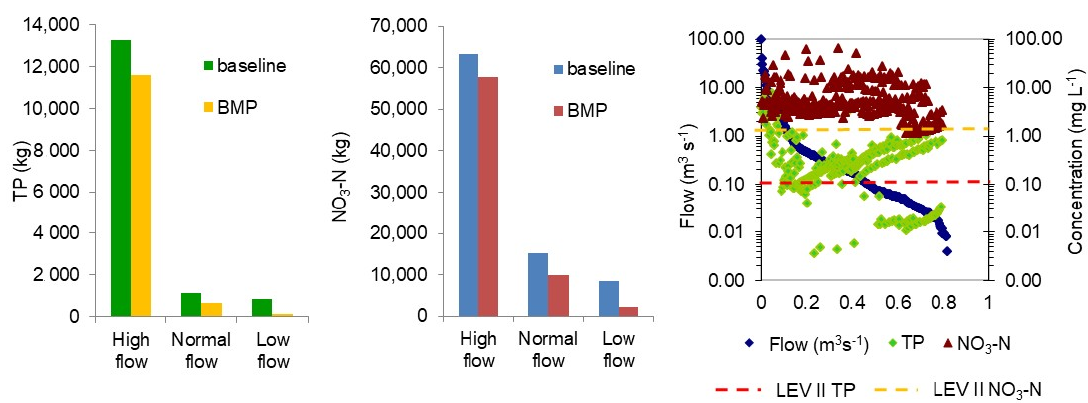
Figure 5. TP and NO 3 -N loads simulated at the outlet under current conditions (baseline) and for a scenario (BMP) that included the reuse of treated wastewater from WWTPs and a reduction in fertiliser usage. The flow duration curve, TP and NO 3 -N concentrations for the BMP scenario are shown.